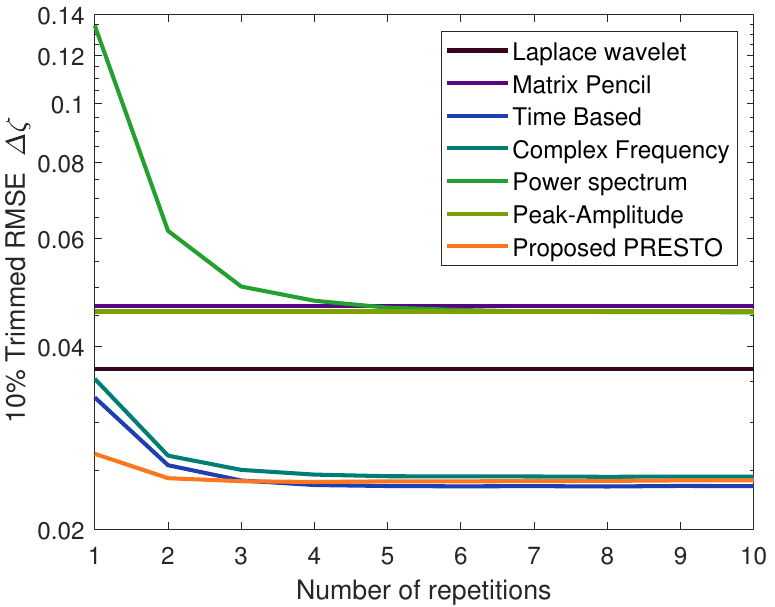
Figure 12. Root mean square error (RMSE) in the estimation of the damping factor ( ζ ) of two simulated underdamped modes excluding the worst 10% of cases of the database. SNR 5 dB. Logarithmic scale. Table 1. Main results of the simulated experiments comparing the average natural frequency error and damping factor RMSE, considering different SNRs. Time Complex Power Matrix Peak Laplace PRESTO Based Freq. Spec. Pencil Amplitude Wavelet Mixed Estim. Estim. Estim. Estim. Estim. Estim. Estim. Num. of reps. 6 6 10